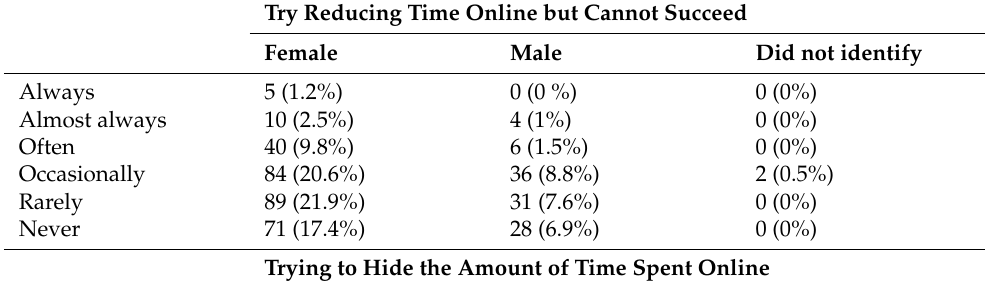
Table 6. Trying to reduce time spent online without succeeding, and hiding consumption, by gender. Try Reducing Time Online but Cannot Succeed Female Male Did not